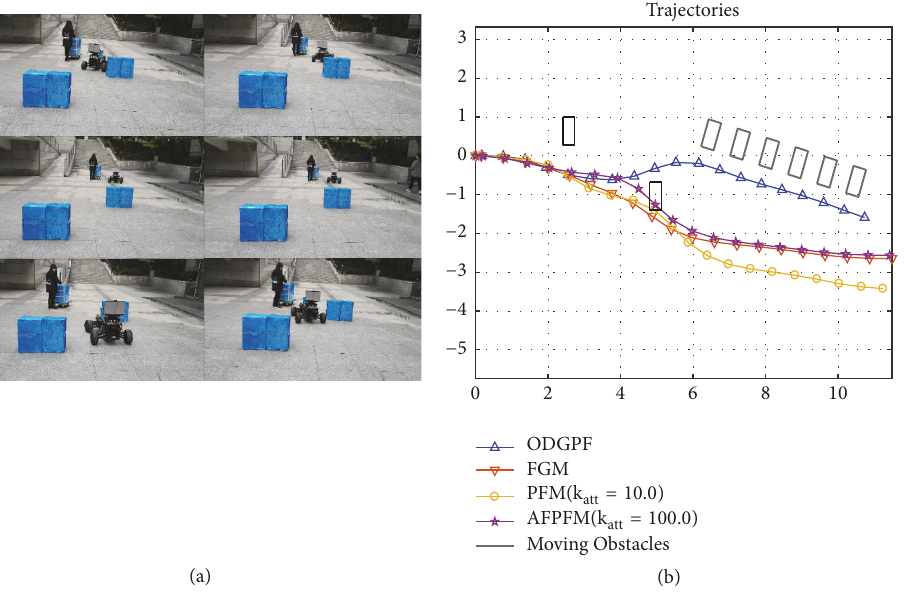
Figure 19: Experimental results of the vehicle with ODG-PF for Scenario